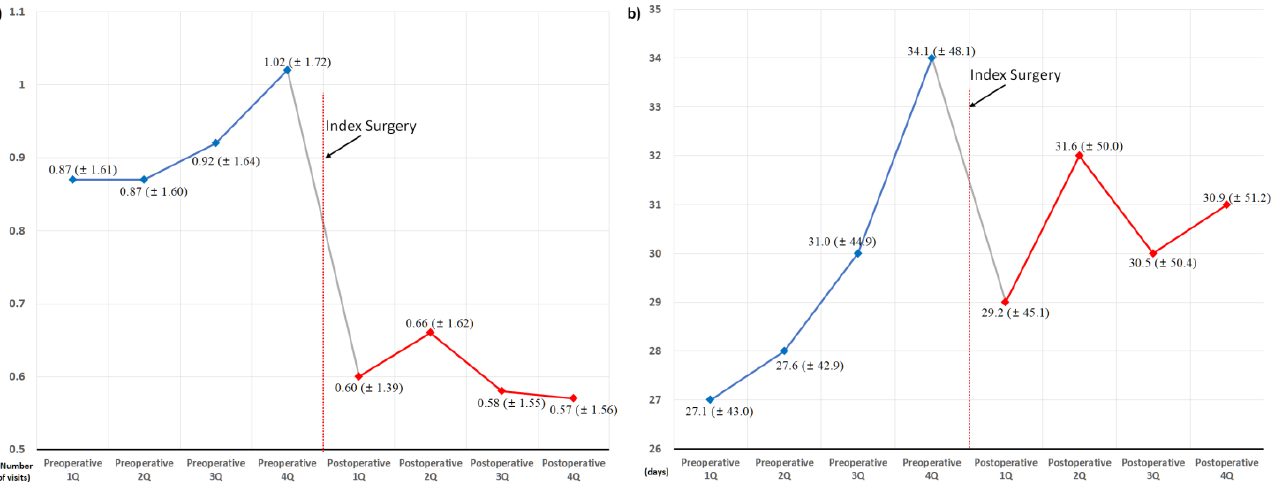
Figure 3. Overall perioperative changes in the use of sleep medication and hospital visits owing to sleep disorder: ( a ) changes in the number of hospital visits, and ( b ) changes in the prescribed duration of sleep medication.